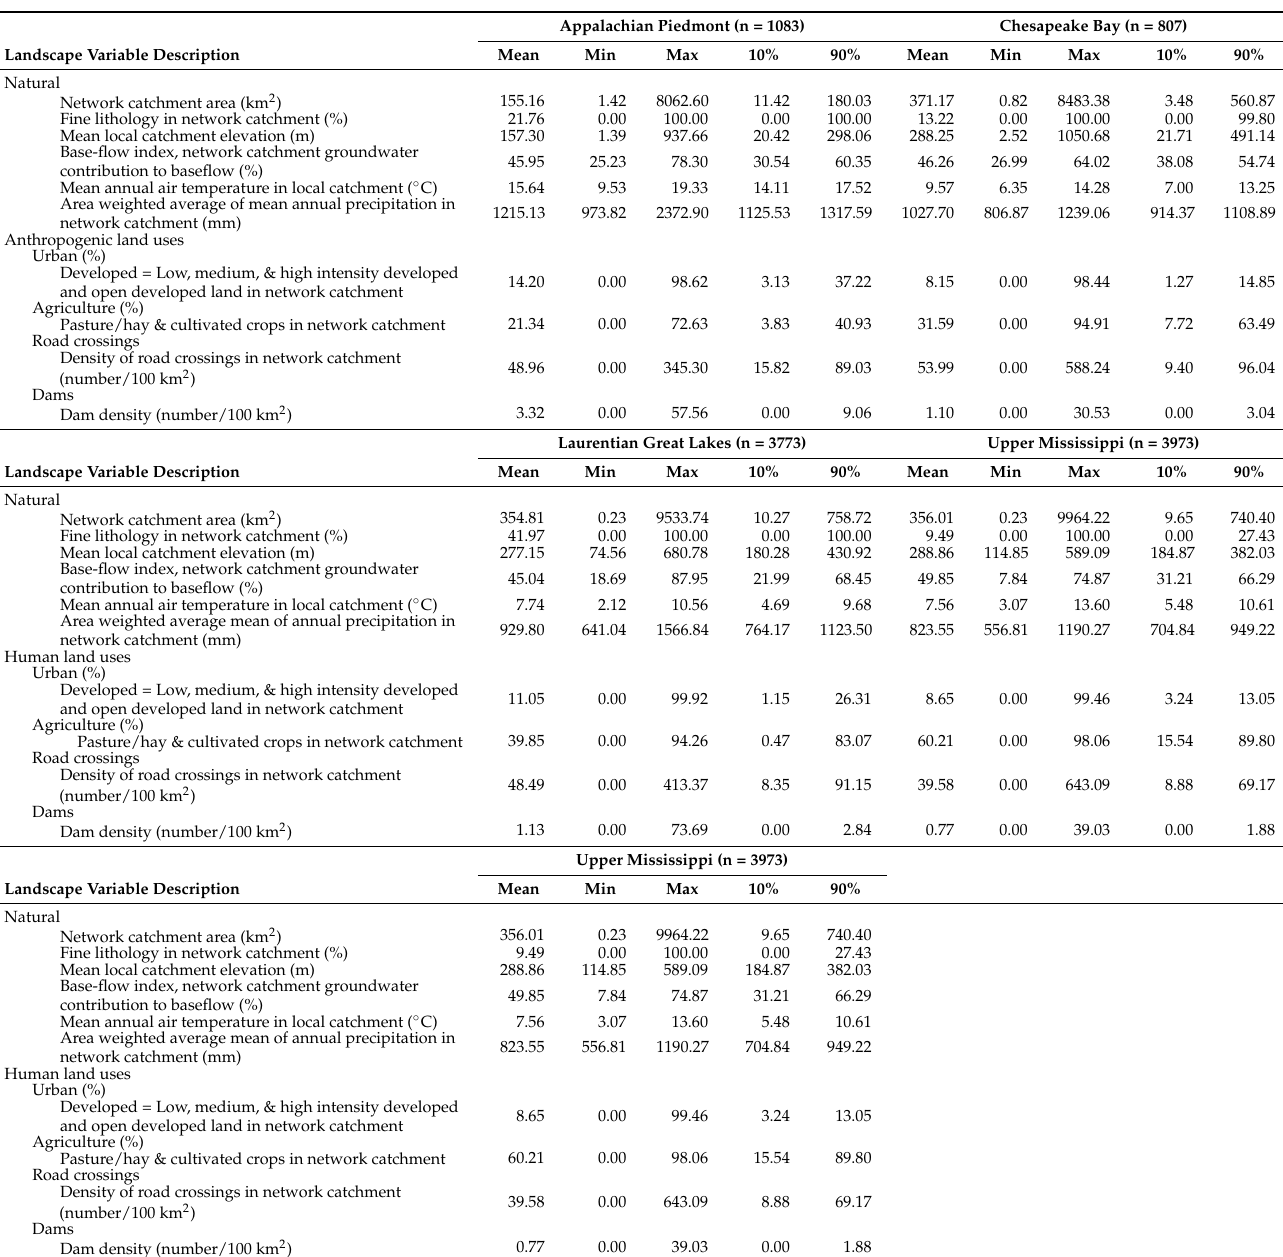
Table 1. Landscape variable descriptions and descriptive statistics of landscape variables for the five freshwater ecoregions (i.e., mean, minimum, maximum, and the 10th and 90th percentile values), with n = number of sample sites by ecoregion. Appalachian Piedmont (n = 1083) Chesapeake Bay (n =